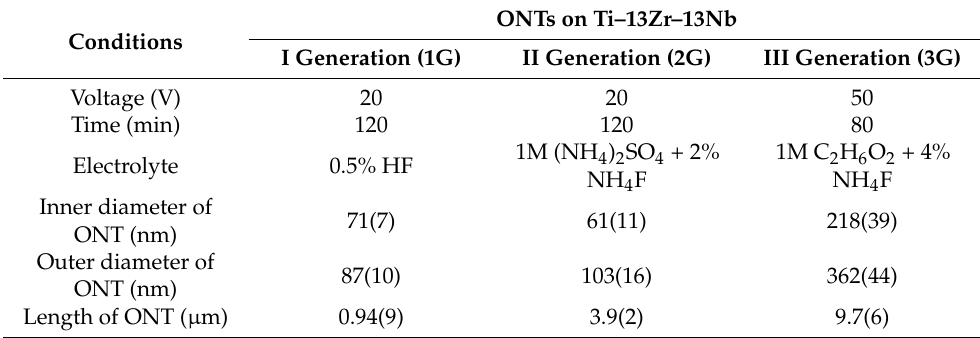
Table 1. Conditions for anodic production of 1G [32], 2G [34], and 3G [31] ONTs on the Ti–13Zr– 13Nb